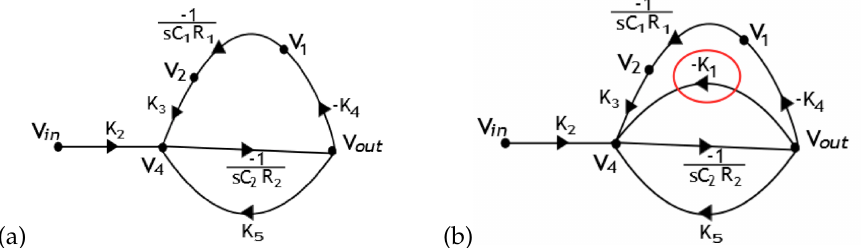
Figure 2. Signal flow graph of the: ( a ) opamp-RC filter shown in Figure 1, and ( b ) augmenting one K 1 from node V out to V 4 . feedback loop labeled −